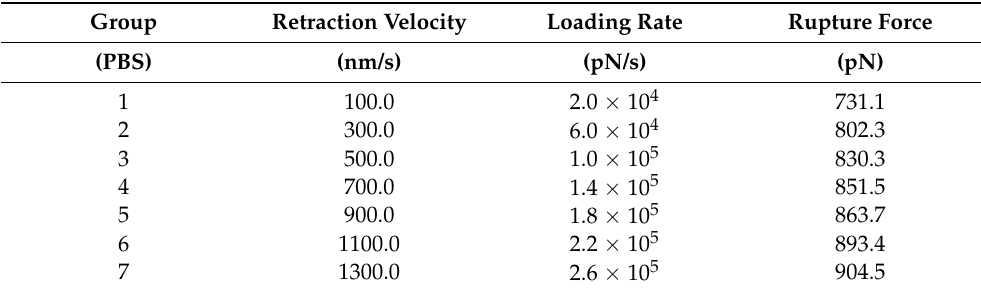
Table 3. The probe retraction velocity, loading rate, and rupture force under different loading rates in the